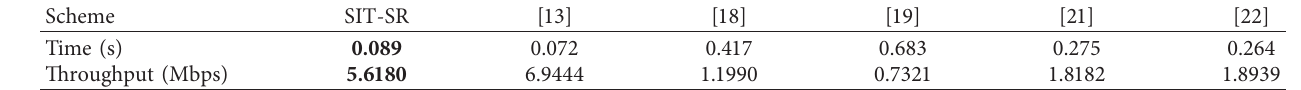
Table 12: Comparison of test results obtained by different encryption schemes to encrypt Lena image.